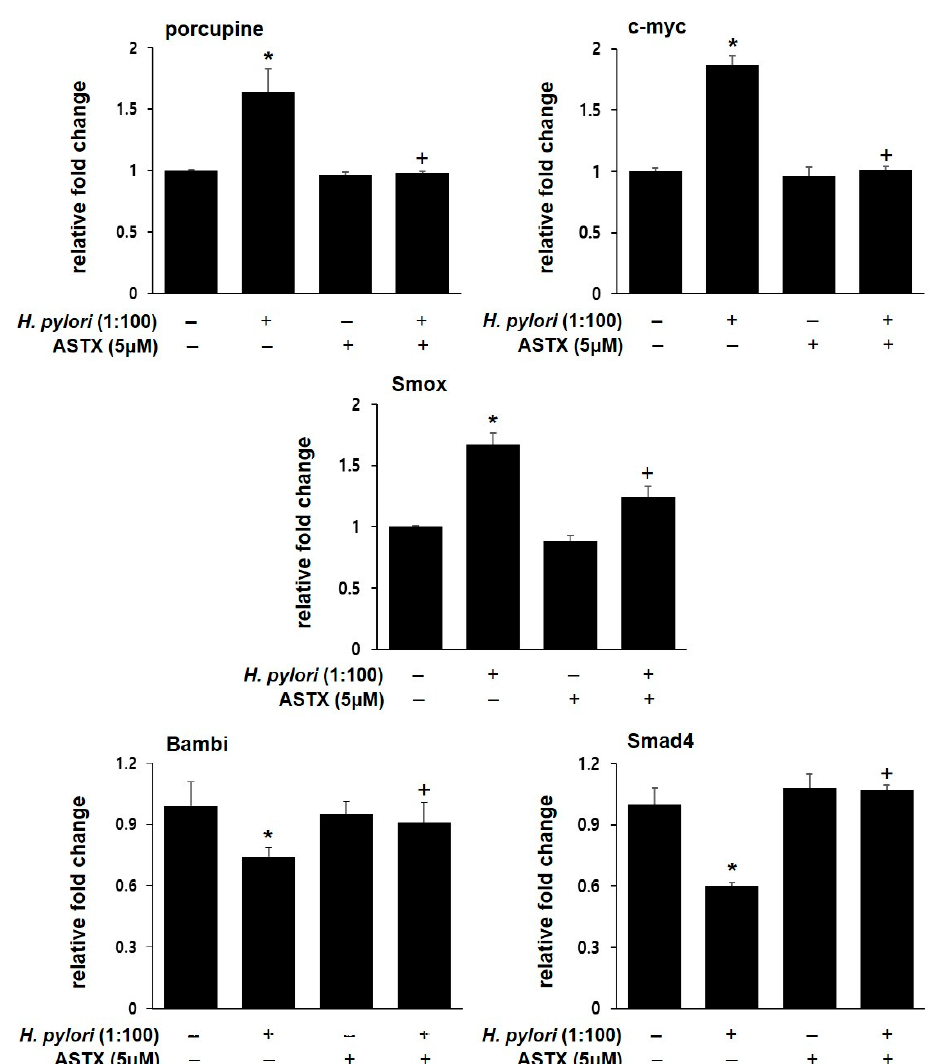
Figure 5. Changes in the mRNA expression of porcupine, c-myc, Smox, Bambi, and Smad4 of H. pylori -infected AGS cells with or without ASTX pretreatment. AGS cells were pretreated with vehicle (DMSO) or 5 µ M ASTX for 3 h and then incubated with H. pylori at a cellular ratio of 100:1 for 4 h. Real-time PCR assay was performed to measure the relative amounts of porcupine, c-myc, Smox, Bambi, and Smad4 mRNA in AGS cells. mRNA levels were normalized to that of β -actin. * p < 0.05 vs. uninfected cells; + p < 0.05 vs. H. pylori -infected cells without ASTX pretreatment.